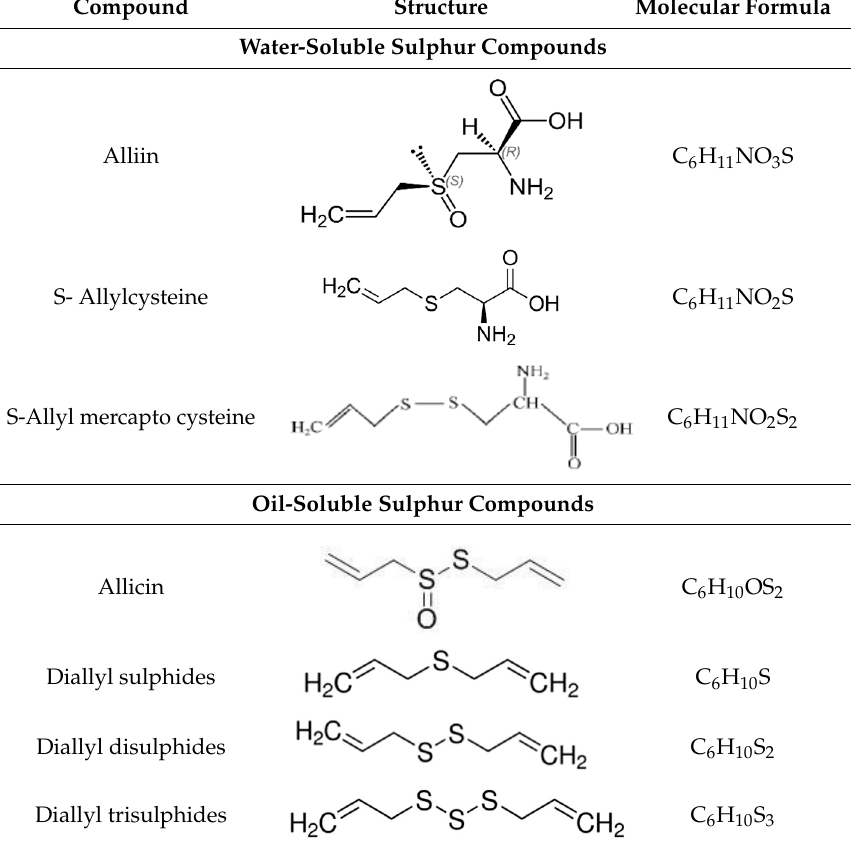
Table 1. Structure and chemical formula of the sulphur based compounds present in garlic.